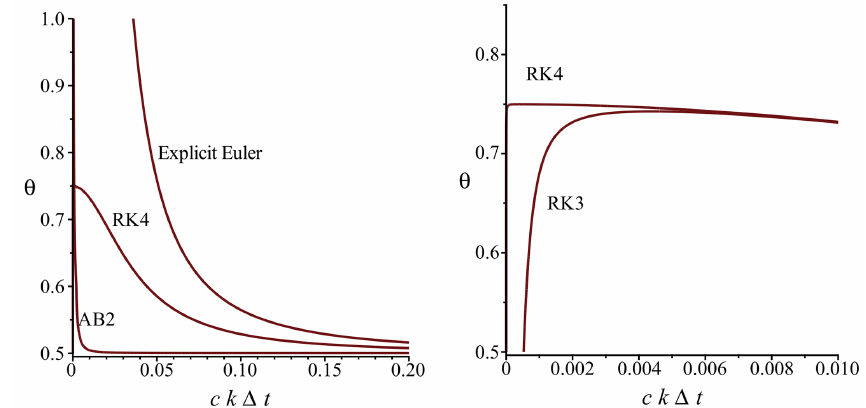
Figure 2. Neutral linear stability level curves in the θ − ck(cid:49)t plane for the θ method for several explicit schemes. The Coriolis parameter f = 10 − 4 rads − 1 , (cid:49)t = 360s. The area above the red curves indicates the stable region for each scheme. Note that RK3 and RK4 are unconditionally stable for all θ ≥ 0 . 75, while AB2 and explicit Euler are both unstable for small wavenumbers k . Table 1. Computational performance of the explicit and barotropic–baroclinic mode split time schemes without nudging, remapping or diffusion for non-adaptive runs with 60 vertical layers for a modified version of the turbulent baroclinic jet case discussed in Sect. 4.3. Patch size is the size of the uniform patches in the hybrid data structure (i.e. the lowest level of the quad tree). The metric used is (wall clock time × cores) / (iterations × nodes × vertical layers), where iterations = 3 for RK3. Grid level J Patch size 20 cores 40 cores 160 cores Explicit Split Explicit Split Explicit Split 7 (163840 cells) 8 × 8 1.23µs 1.33µs 1.42µs 1.46µs 7 (163840 cells) 16 ×